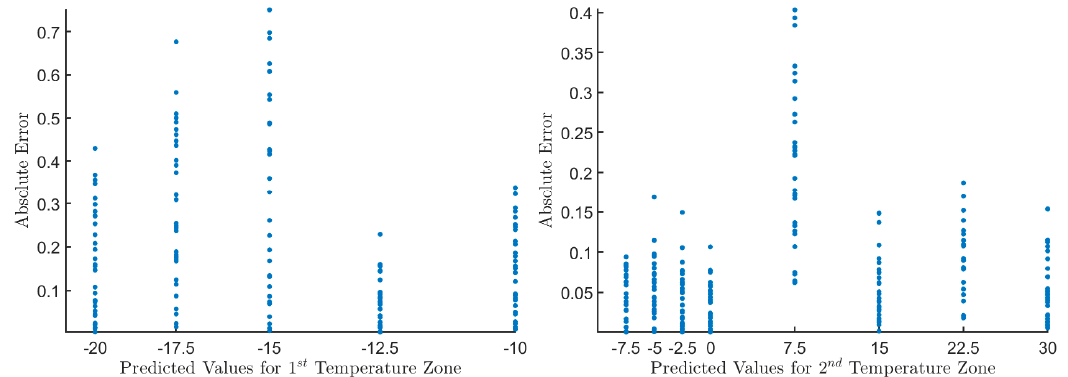
Figure 4. The AE regarding predicted values for both temperature areas. The AE for each sampled value is depicted with blue dots. The x ‐ axis shows the temperatures, while on the y ‐ axis, the AE, which was calculated using Formula (7). The left diagram shows the 1st temperature zone’s measurement results where the AE ranged from 0 °C to 0.75 °C. The right diagram shows the 2nd temperature zone’s measurement results, where the AE went from 0 °C to 0.4 °C.